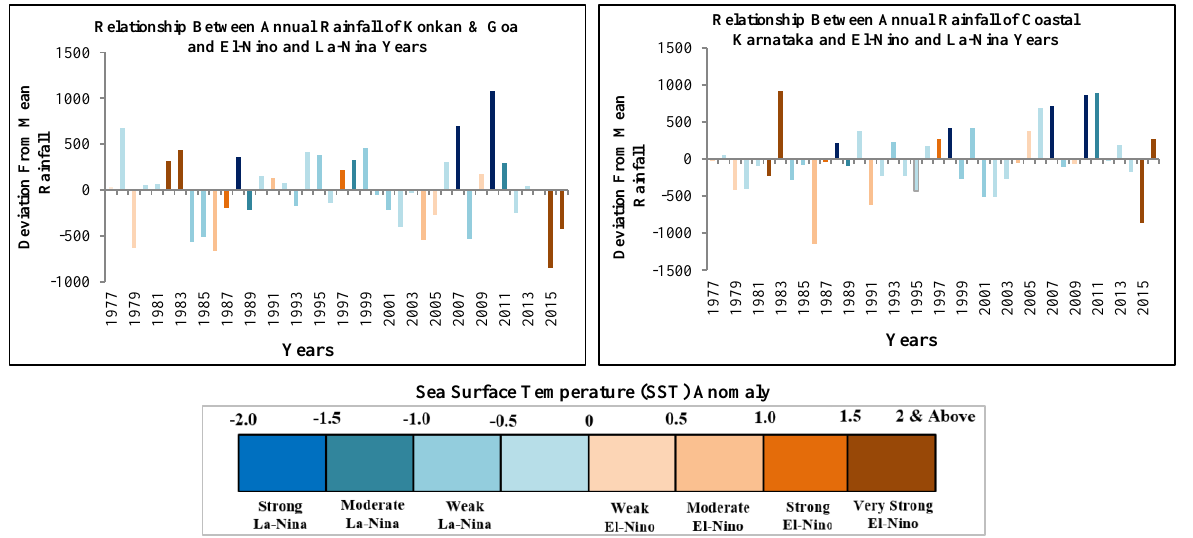
Figure 13. Relationship between annual rainfall and El-Nino and La-Nina